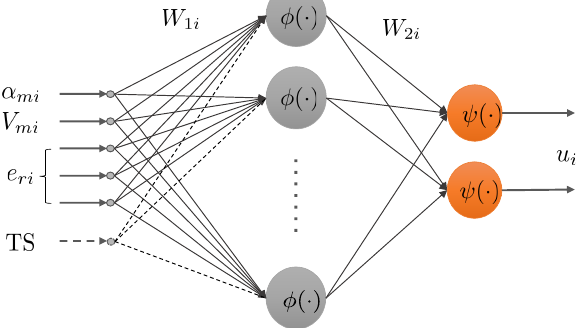
Figure 3. Neural network controller